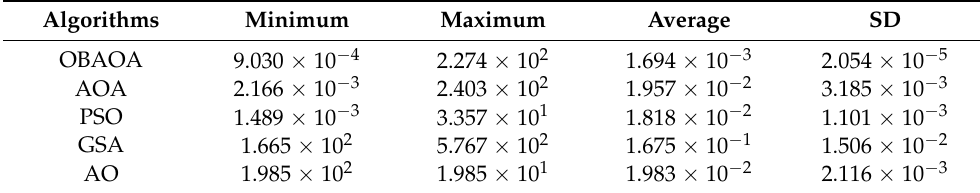
Table 7. Statistical results of Ballard Mark V Fuel cell.